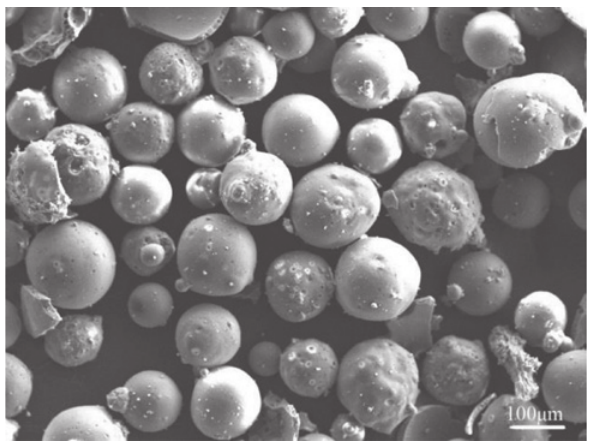
Figure 1: SEM microstructure showing the morphology of FAC